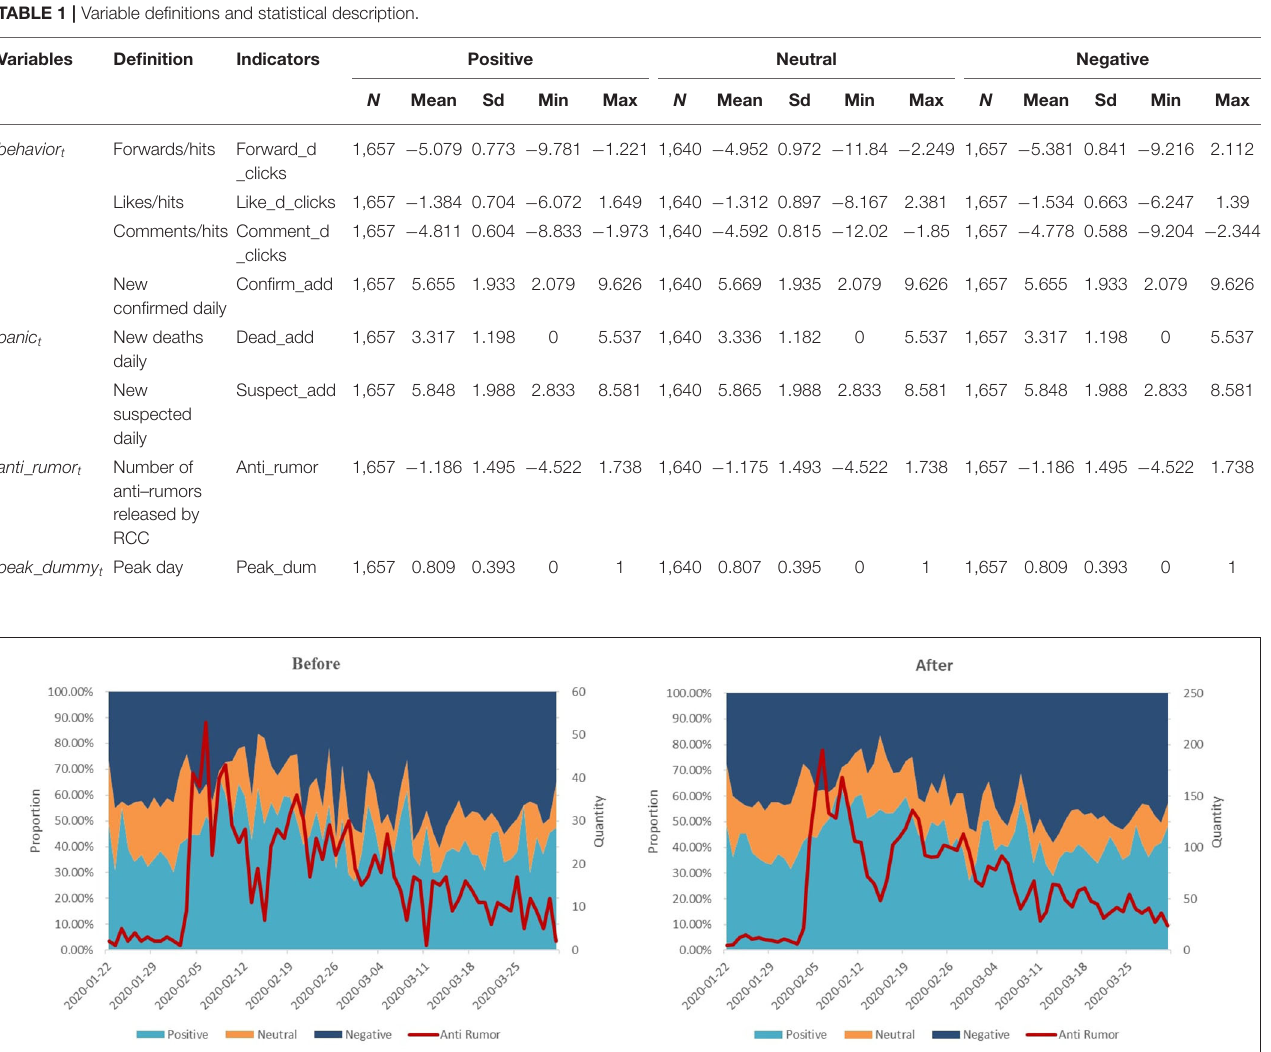
FIGURE 1 | Daily accumulation graph of positive, negative, and neutral news and the number of anti-rumors before (left) and after (right) the “48-h allocation.” The primary vertical axis represents the proportion of positive, neutral and negative rumors, while the secondary vertical axis represents the strength of the rumor-refuting